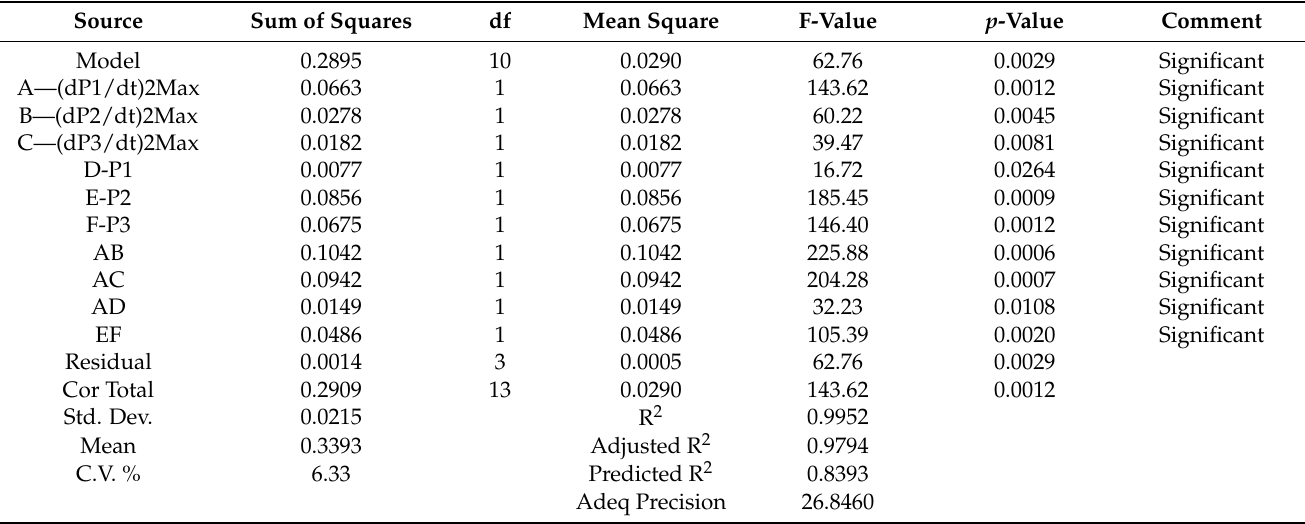
Table 5. ANOVA total rejection rate and in-die sensing